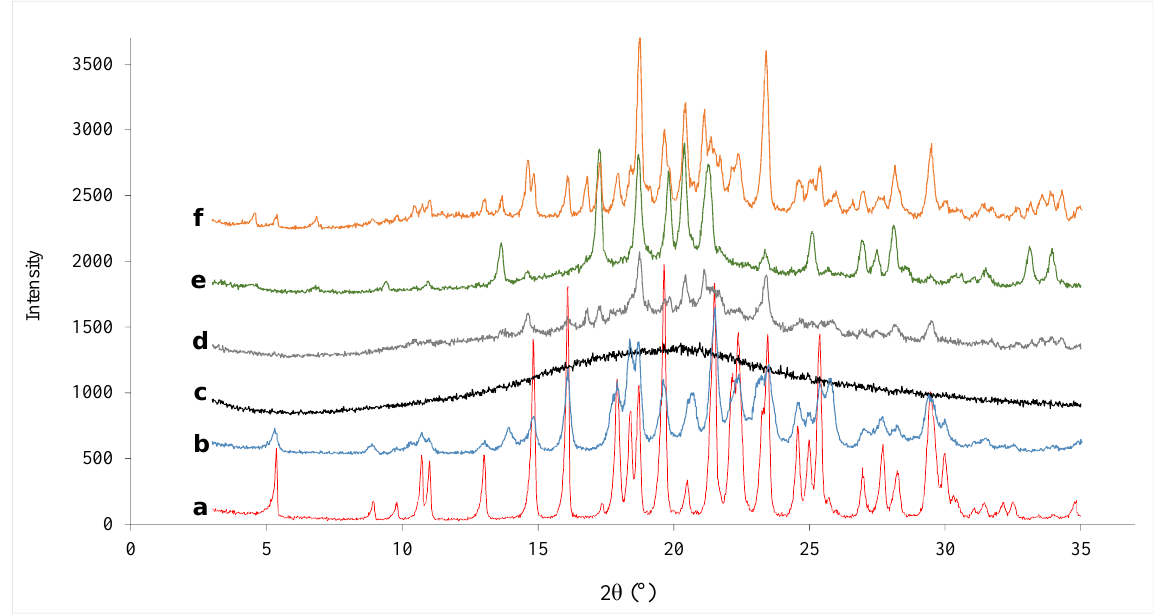
Figure 7. X-ray diffraction patterns of: (a) CXB pure powder, (b) milled CXB, (c) co-milled CXB with